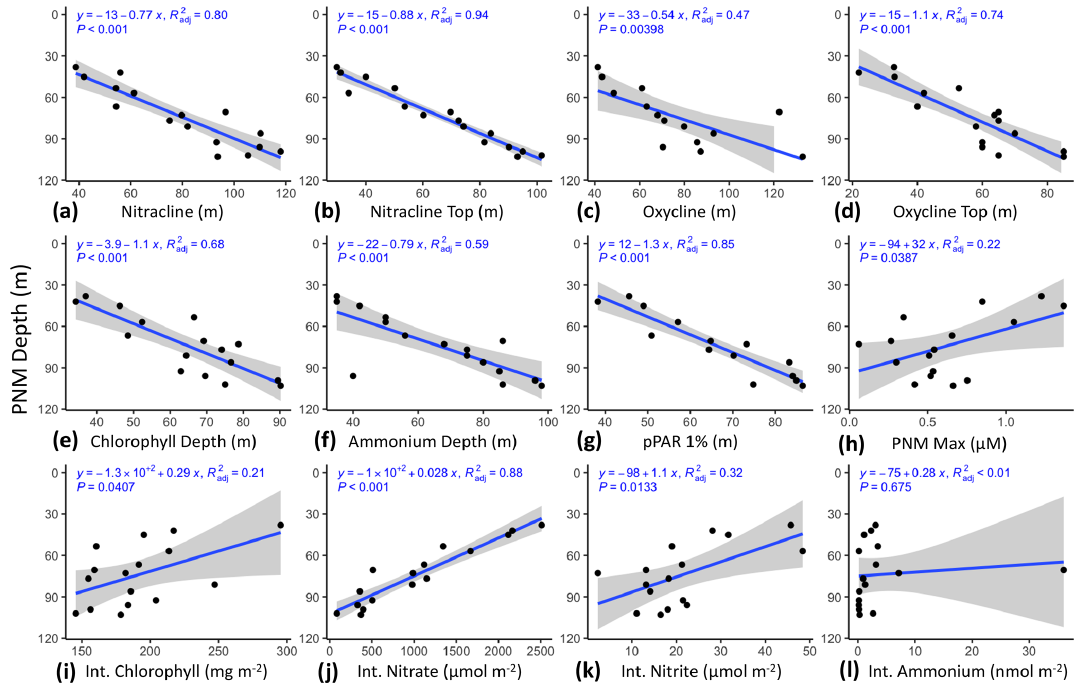
Figure 3. Linear regression of Z NO against water column features from data collected during the 2016 cruise using the PPS. Depth of 2 the nitrite maxima was regressed against (a) Z mnit , (b) Z nit , (c) Z moxy , (d) Z oxy , (e) Z chl , (f) Z NH (j) NO − _Int, (k) NO − _Int and (l) NH + _Int. PPS station data from 2016 ( n = 16). Shaded region shows standard 3 2 4